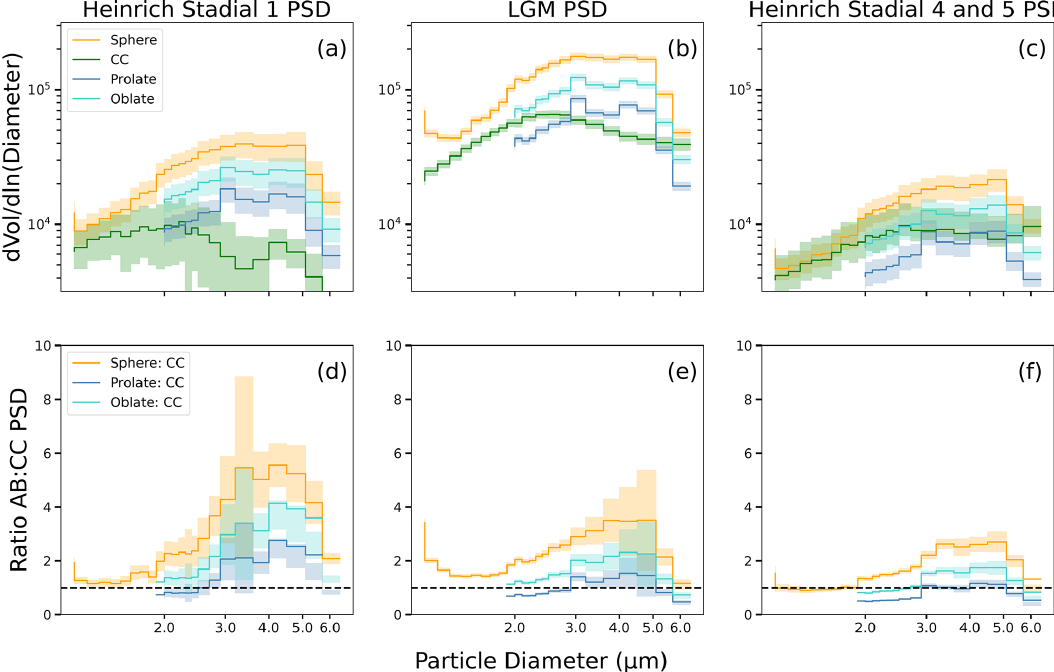
Figure 3. Comparison of Abakus volume and calibration schemes (Eqs. 1, 3a, 3b, 3c) to Coulter counter data (a–c) and the ratio of particle size distributions between Abakus and Coulter counter data (d–f) . Sphere: Abakus sphere PSD calculation (length = width = height), CC: CC PSD calculation (accurate volume), prolate: Abakus prolate PSD calculation (width = height), oblate: Abakus oblate PSD calculation (length = height). The top panel compares the PSD Abakus volume and calibration techniques to PSD CC , and the bottom panel is the ratio of each PSD Abakus to the PSD CC in different time periods. The dotted line in the lower panels represents a 1 : 1 value, and the closer each colored line is to the 1 : 1 line, the lower the total offset. Using ellipsoidal volume calculations always improves methodological correspondence, although the type of ellipsoid that best fits the data depends on particle size. For a comparison of all calculations and calibrations see Fig.